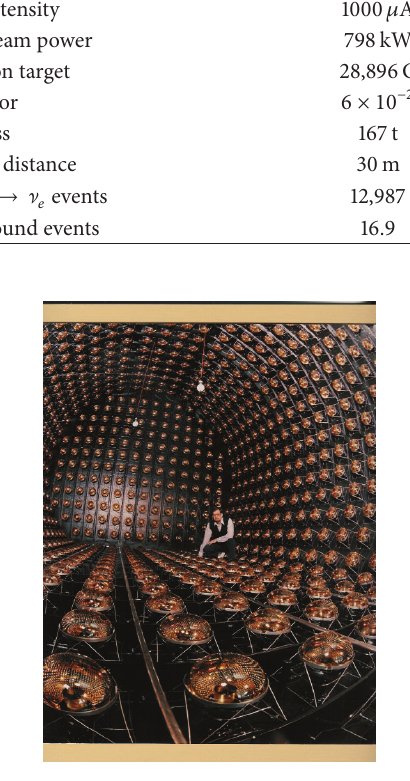
Figure 1: A photograph of the inside of the LSND detector